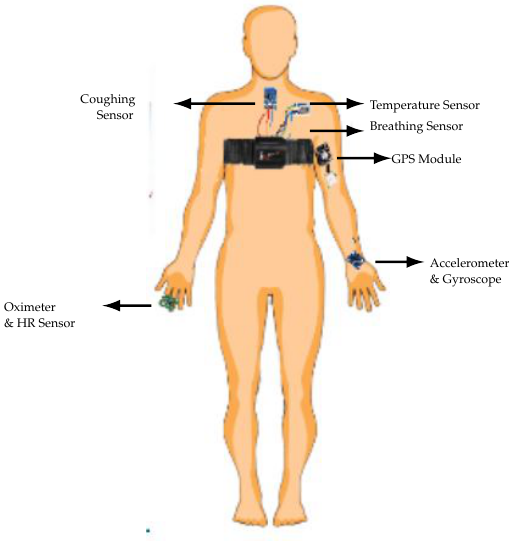
Figure 5. Wearable sensors placement on COVID patients.